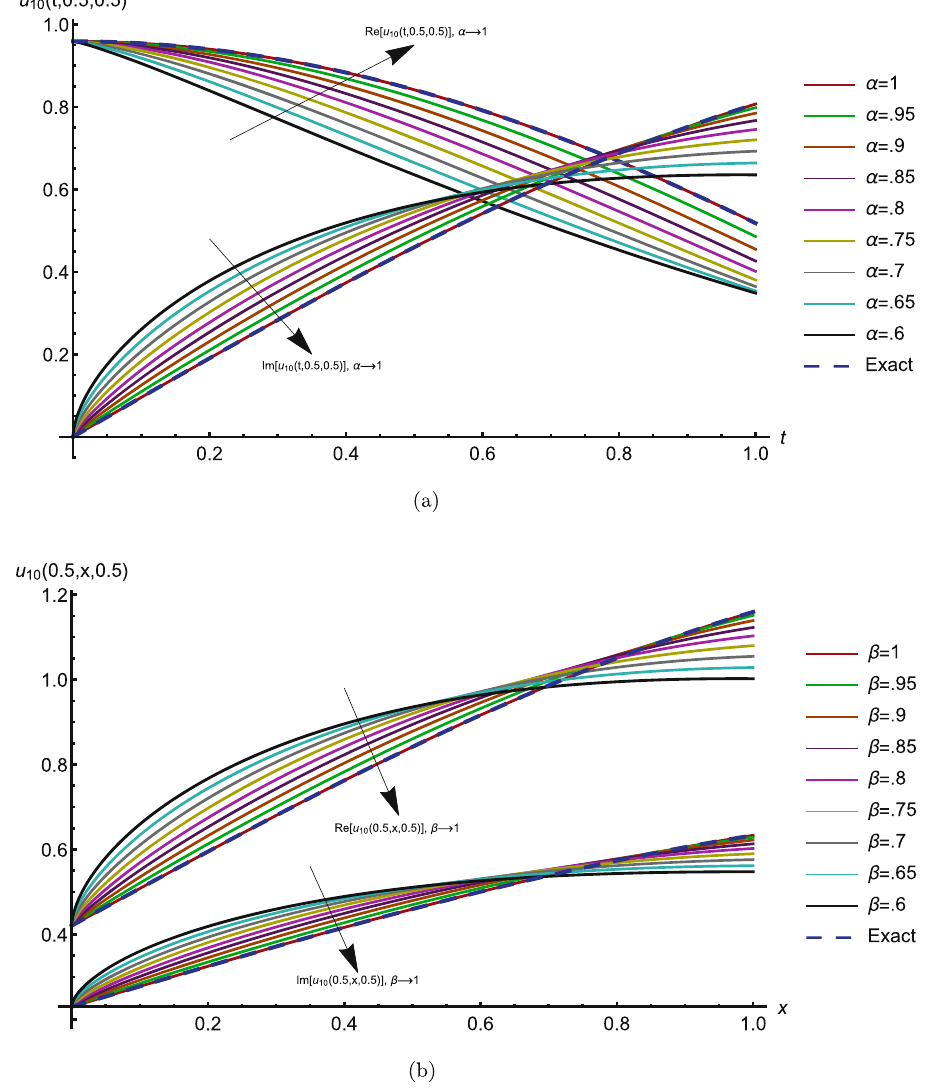
Figure 1: The cross - section behavior of u t x y , , 10 ( ) for ( 3.11 ) at various values of α β γ , , ∈ ( 0,1 ) . ( a ) β γ 1 = = . ( b ) α γ 1 = =